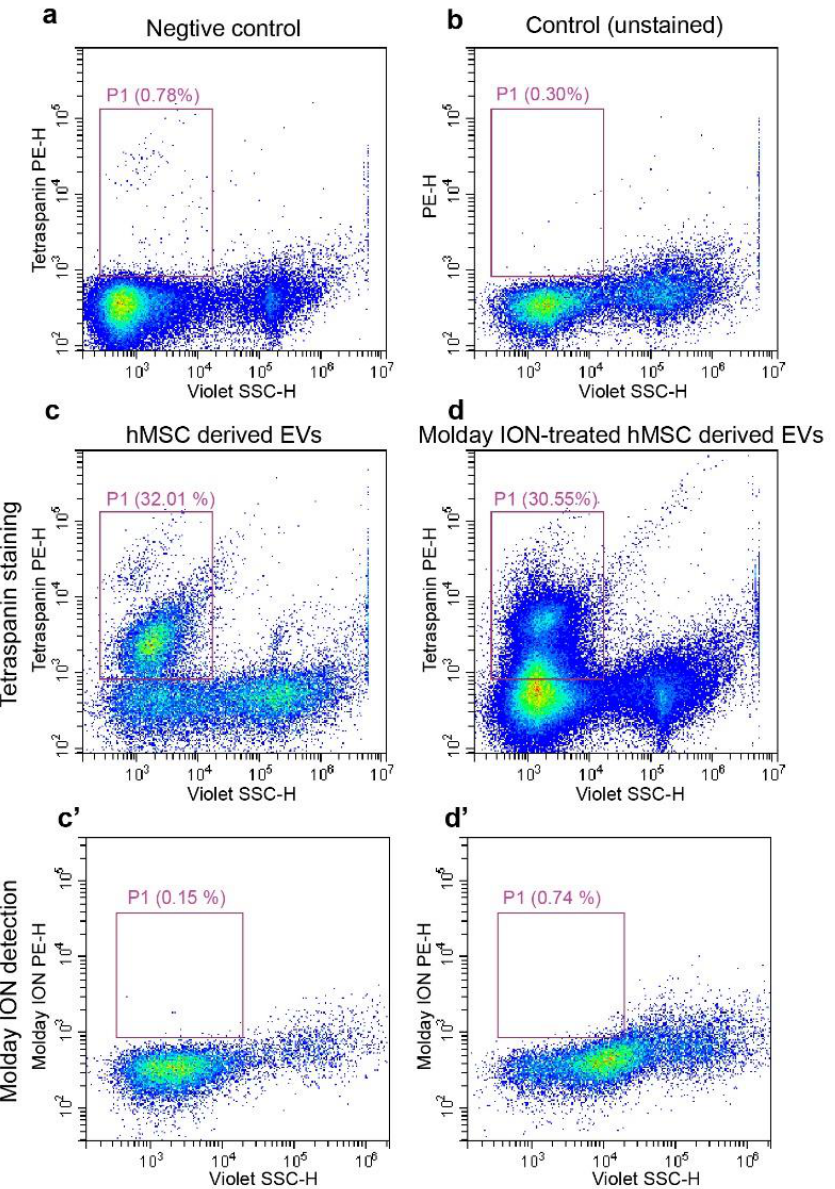
Figure 4. Flow cytometry analysis on isolated EVs: Liposomes stained with tetraspanin and unstained EVs isolated from hMSCs were used as negative control ( a ) and regular control ( b ), respectively. The representative flow cytometry images of tetraspanin positive for EVs from control ( c ), and Molday ION-treated hMSCs ( d ). Molday ION detection in EVs from untreated ( c’ ) and Molday-treated hMSCs ( d’ ).